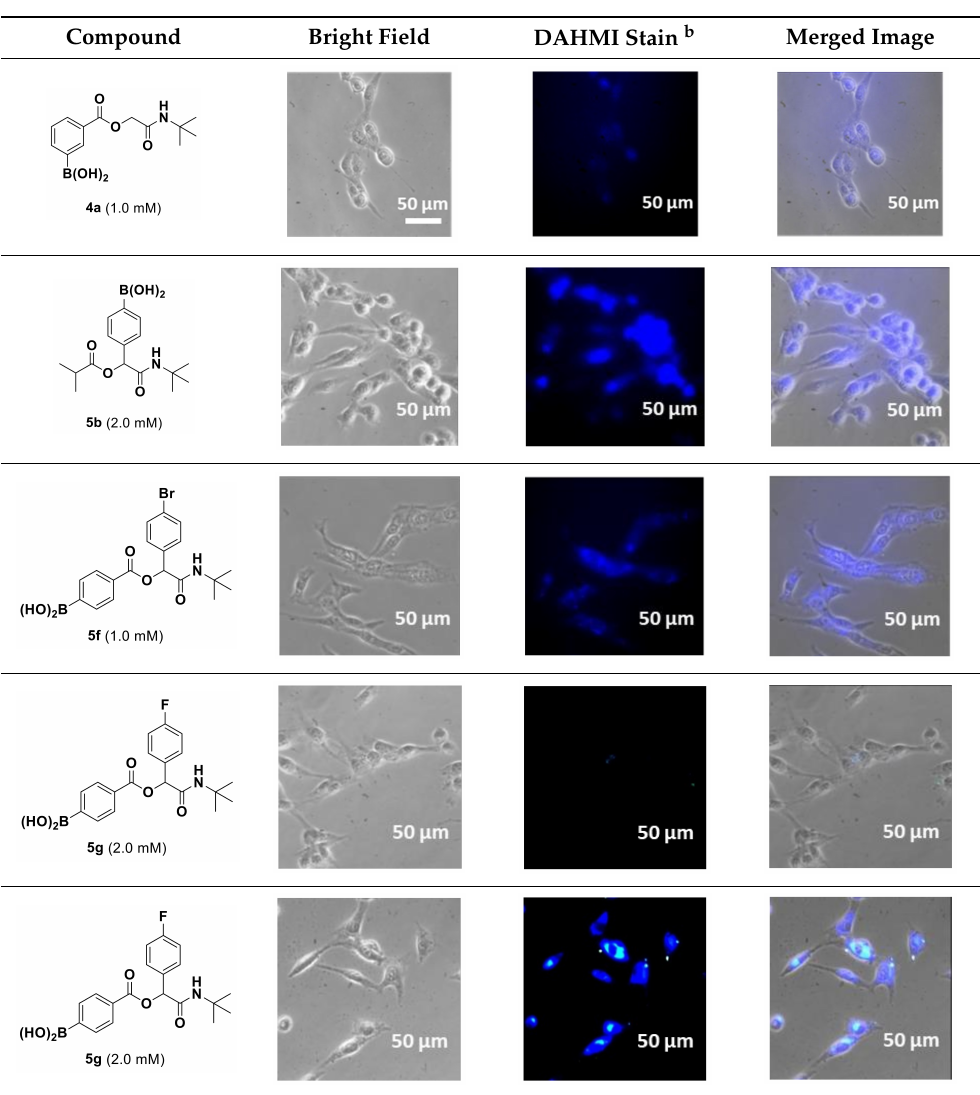
Table 5. Cellular bio-distribution of compound 4a , 5b , 5f , 5g and 5k a